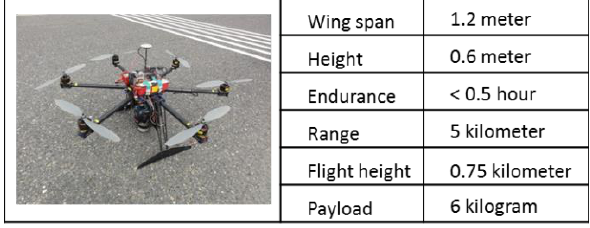
Figure 1 Proposed multi-rotor UAV platform